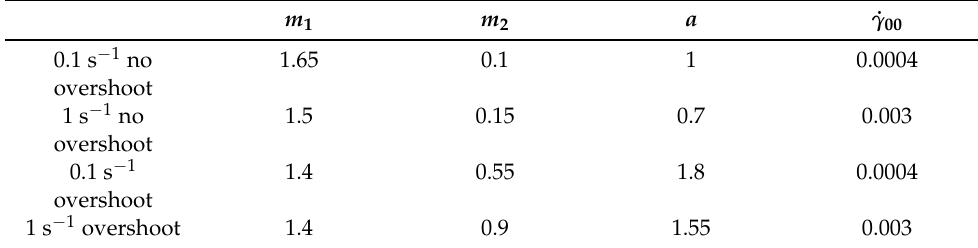
(color: light grey) to the shear rate history with overshoot, and the curve with discrete points (color: light blue) the observed one. The time evolution of shear strain γ ( t ) could be obtained by integrating Equation (16) with respect to time t . Table 2. Values of parameters of the function Equation (16) for shear rate